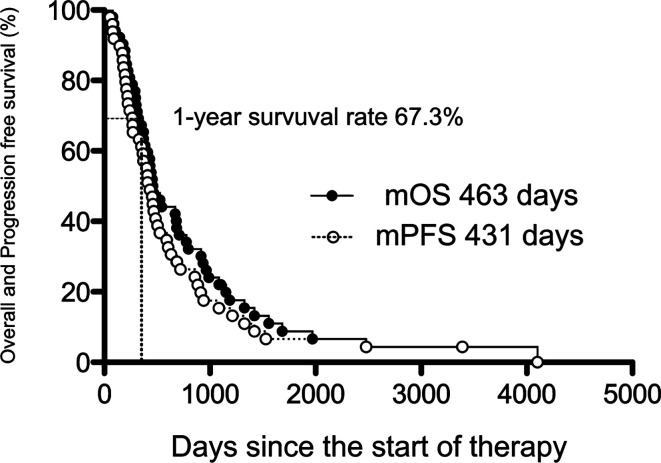
The median overall and progression-free survival of AI+RT in biliary tract cancer (BTC). Kaplan-Meier estimates of the mOS and mPFS. The mOS, mPFS, and 1-year survival rate were 463 and 431 days (15.4 and 14.3 months) and 67.3%, respectively.